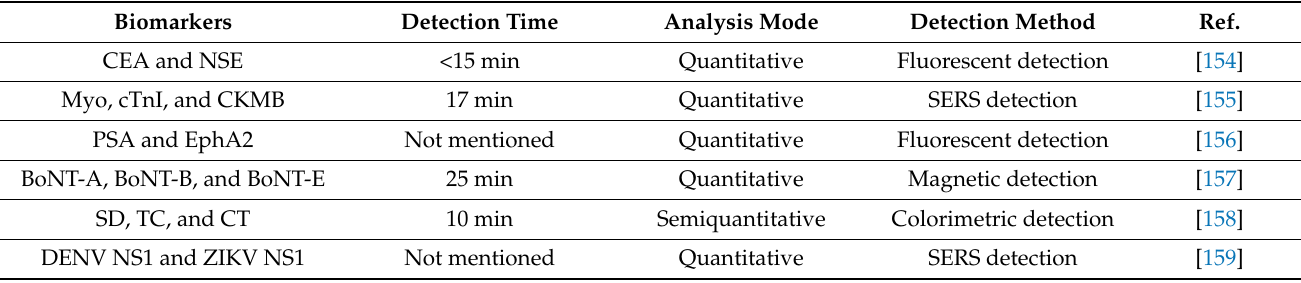
Table 4. QD-based biomarkers in multiplex detection of viral